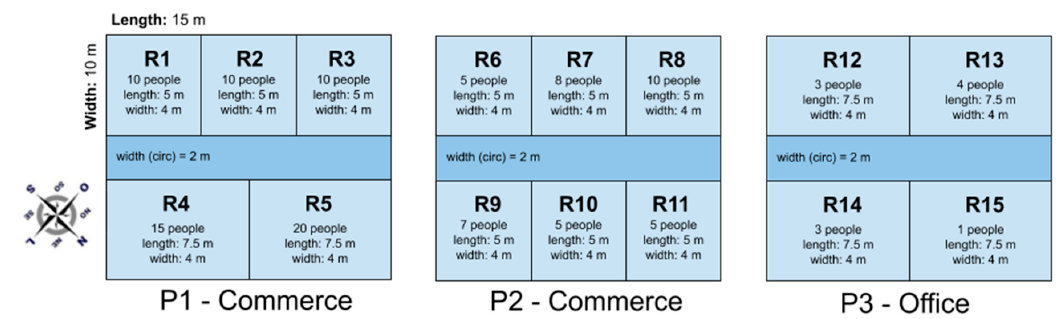
Figure 5. Model building rooms and floors layout, with number of users per room and dimensions.